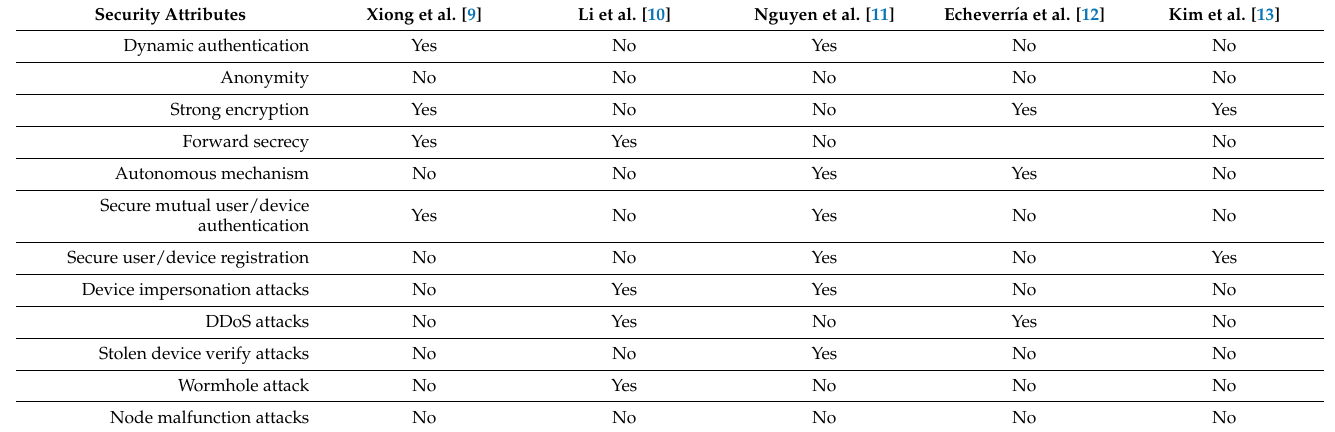
Table 2. Key security breaches in IoT (IIoT/IoMT) security